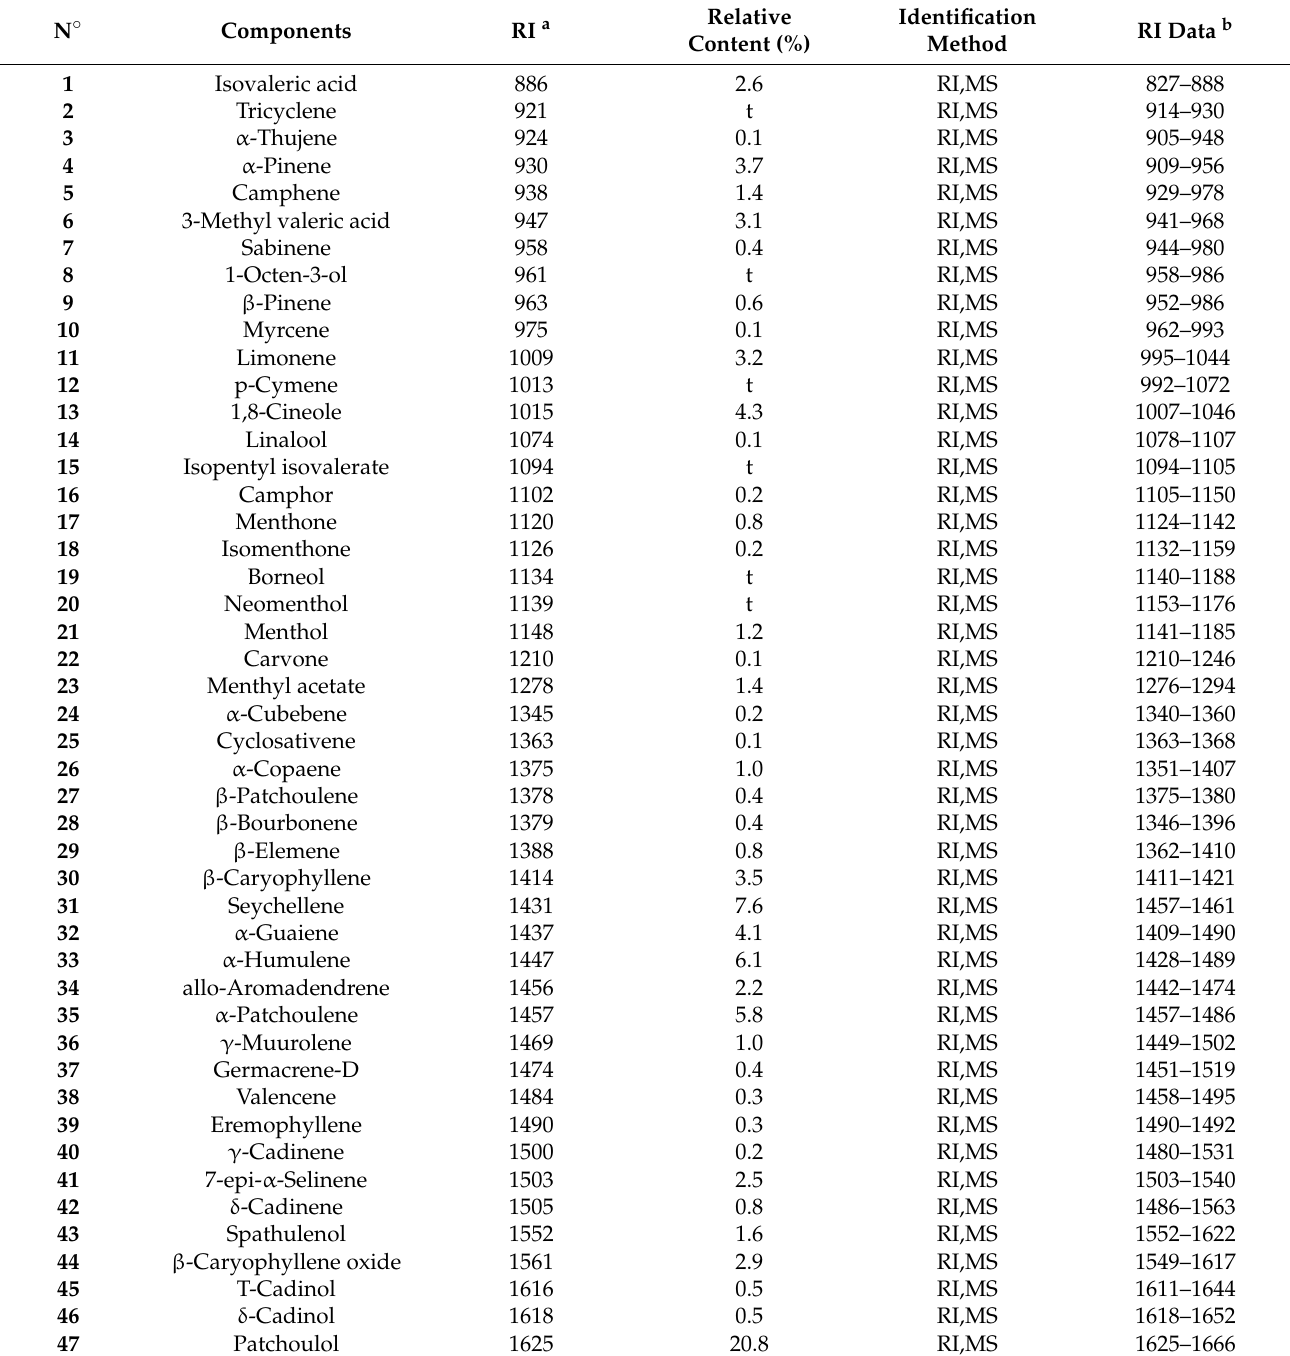
Table 1. Percentage composition of the essential oil isolated from Valeriana pilosa R and P roots collected in Cajamarca,